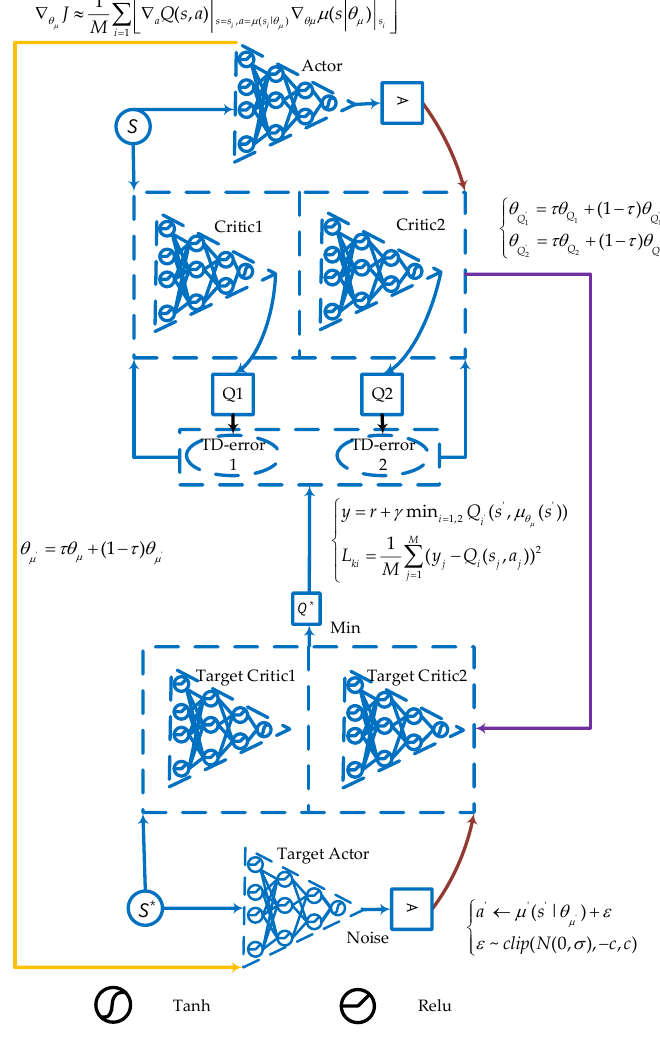
Figure 2. Architecture of TD3.